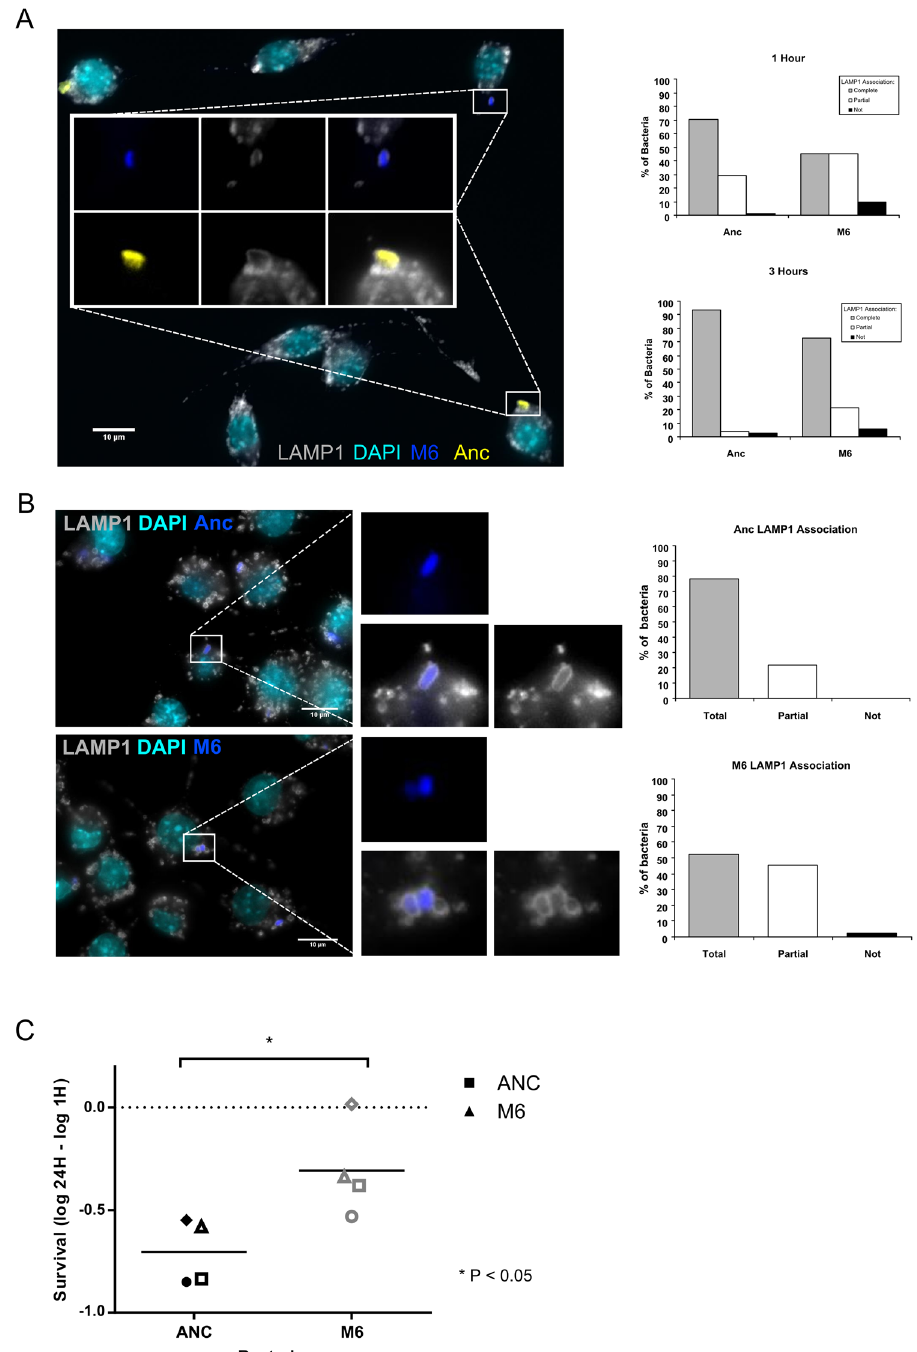
Figure 2. M6-containing phagosomes mature slower and M6 bacteria show enhanced survival inside macrophages. ( A ) Representative fluorescence image of M Φ s at 1 h post-infection. Anc bacteria are shown in yellow and the M6 evolved clone in blue. LAMP1 is shown in grey and DNA in cyan. Quantification of LAMP1 association at 1 h and 3 h post-infection. Scale bar: 10 µ m. ( B ) Representative fluorescence images of macrophages 1 h post-infection performed in parallel with Anc (top panel) and M6 (lower panel) bacteria. LAMP1 is shown in grey, DNA in cyan and bacteria in blue. Quantification of LAMP1 association at 1 h post- infection is plotted. Scale bars: 10 µ m. ( C ) Survival of Anc and M6 bacteria inside macrophages assessed 24 h post-infection. Each symbol represents one experiment and the bar represents the average survival of four independent experiments. * P < 0.05, Mann-Whitney